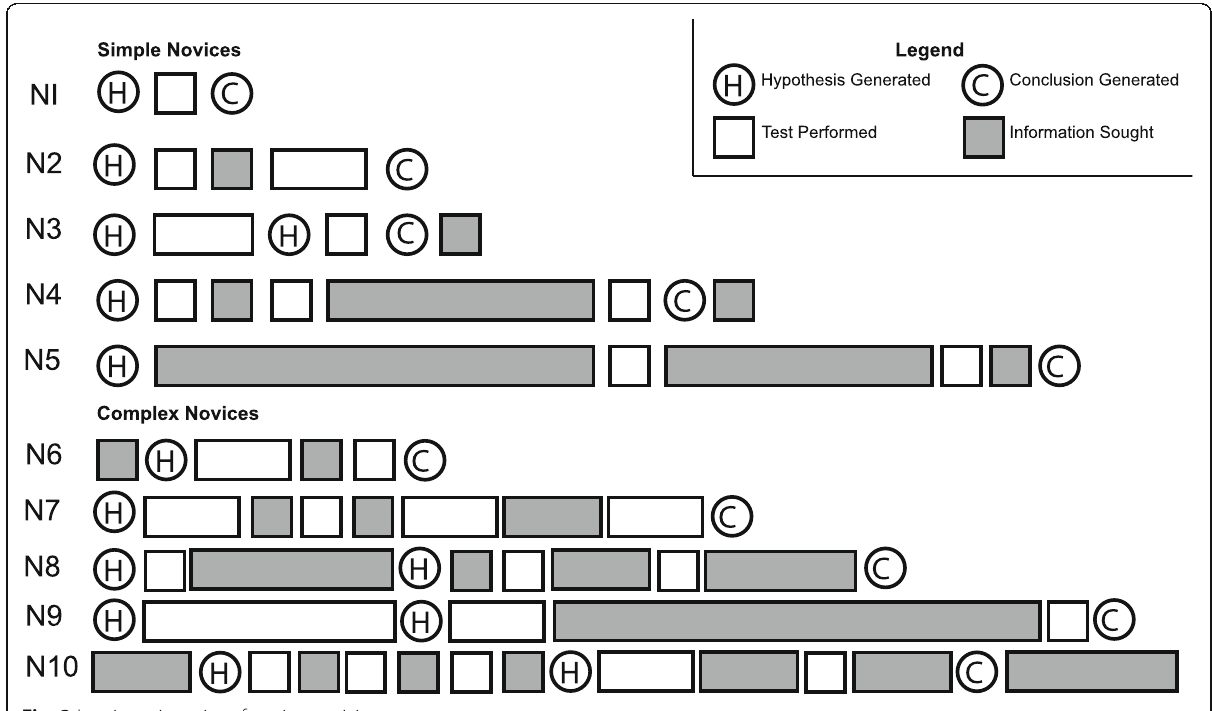
Fig. 3 Inquiry trajectories of novice